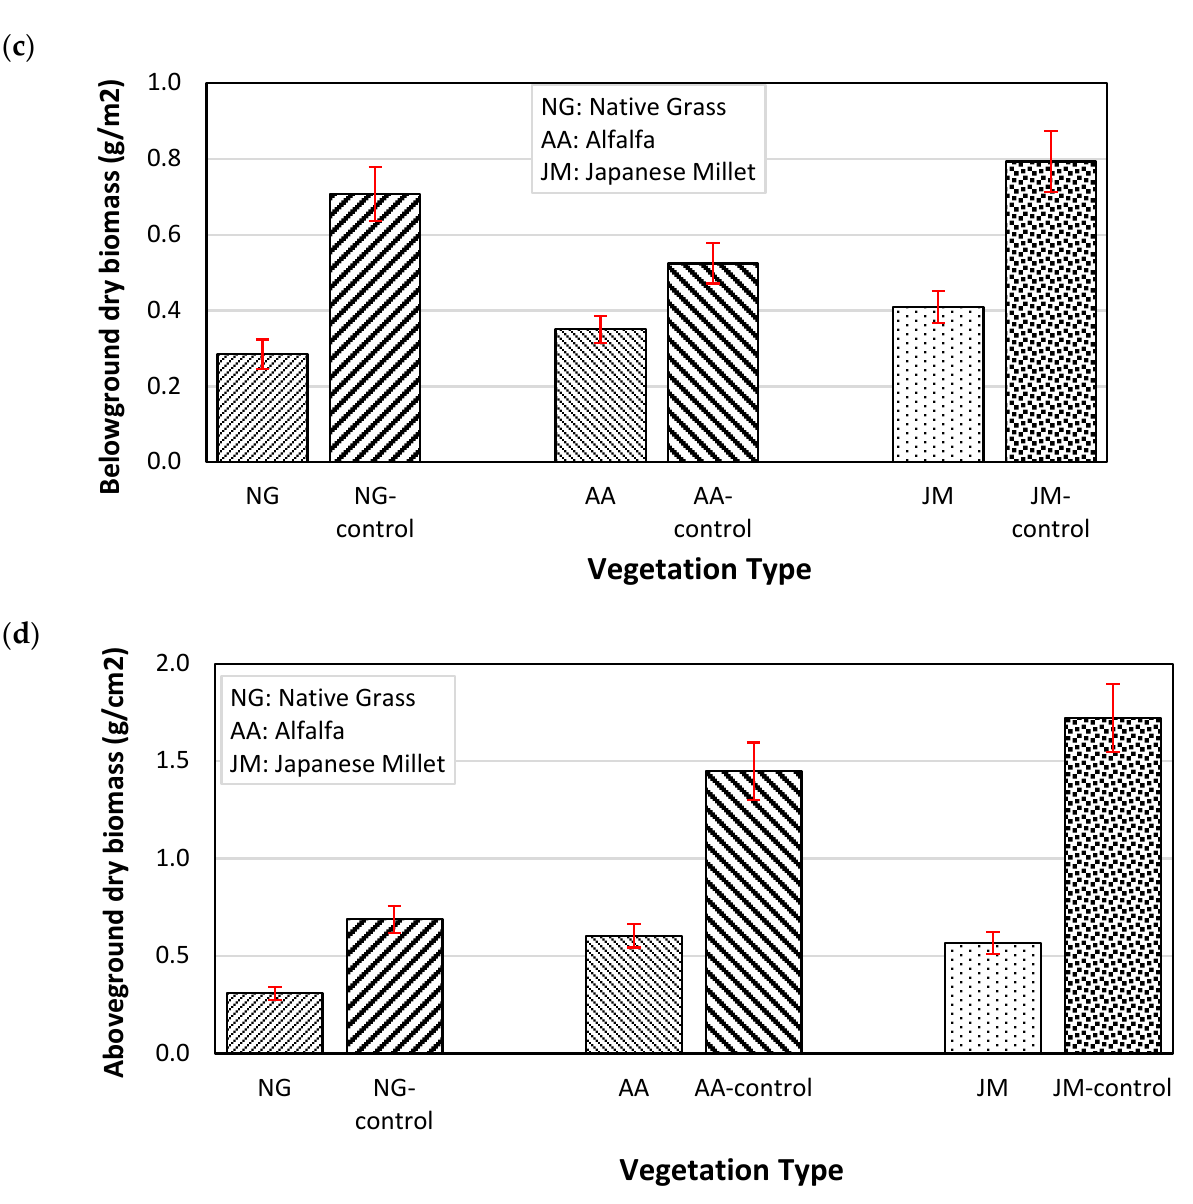
Figure 3. Comparison of vegetation characteristics under natural gas exposure and control (with no exposure); ( a ) Plant heights ( b ) Root lengths ( c ) Below-ground dry biomass densities ( d ) Above- ground dry biomass densities (NG: native grass, AA: alfalfa and JM: Japanese millet). Figure 3a, representing the impact of CH 4 gas exposure on plant height, shows that the highest plant height reductions were observed in native grass, with average reductions for the three replicates of 49.2%, 40.5%, and 61.0% in comparison with control columns, on day 35, day 50, and day 65, respectively. The lowest corresponding reductions of 25.0%, 23.4%, and 18.8% were observed for alfalfa, whereas the reductions for Japanese millet were 37.5%, 31.0%, and 31.5%. Similarly, as shown in Figure 3b, root length decreases of 35.9%, 35.0%, and 34.6% were observed for native grass after day 35, day 50, and day 65, respectively. Corresponding reductions were 25.0%, 26.1%, and 16.7% for alfalfa, and 21.4%, 19.0%, and 25.0% for Japanese millet. The results of the two-way ANOVA revealed statistically significant differences in plant height between the gas-exposed and control columns in both the native grass and alfalfa groups, with p -values of p = 0.049 for NG- gas vs. NG-control and p < 0.001 for AA-gas vs. AA-control. Similarly, the analyses showed statistically significant differences in root length between the gas-exposed and